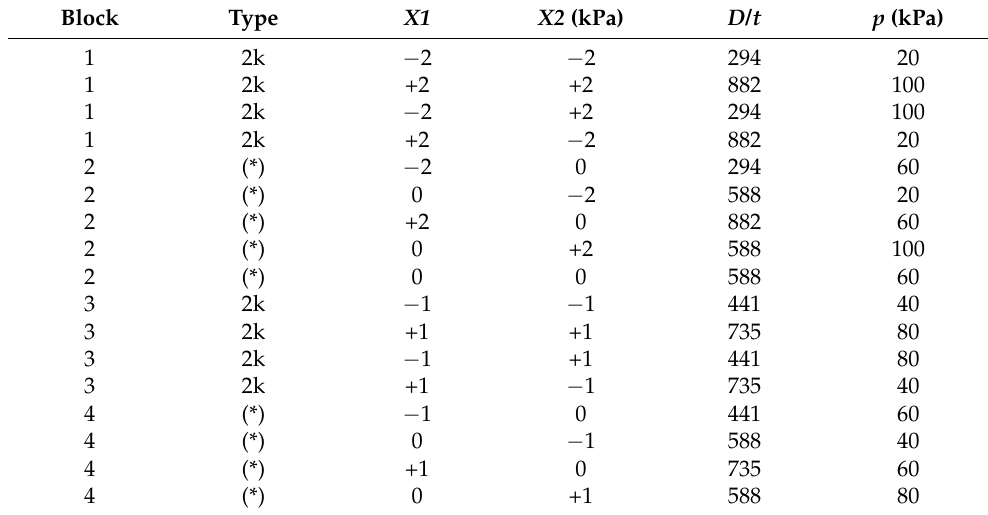
Table 1. Design of experiments for the parametric analysis plan of